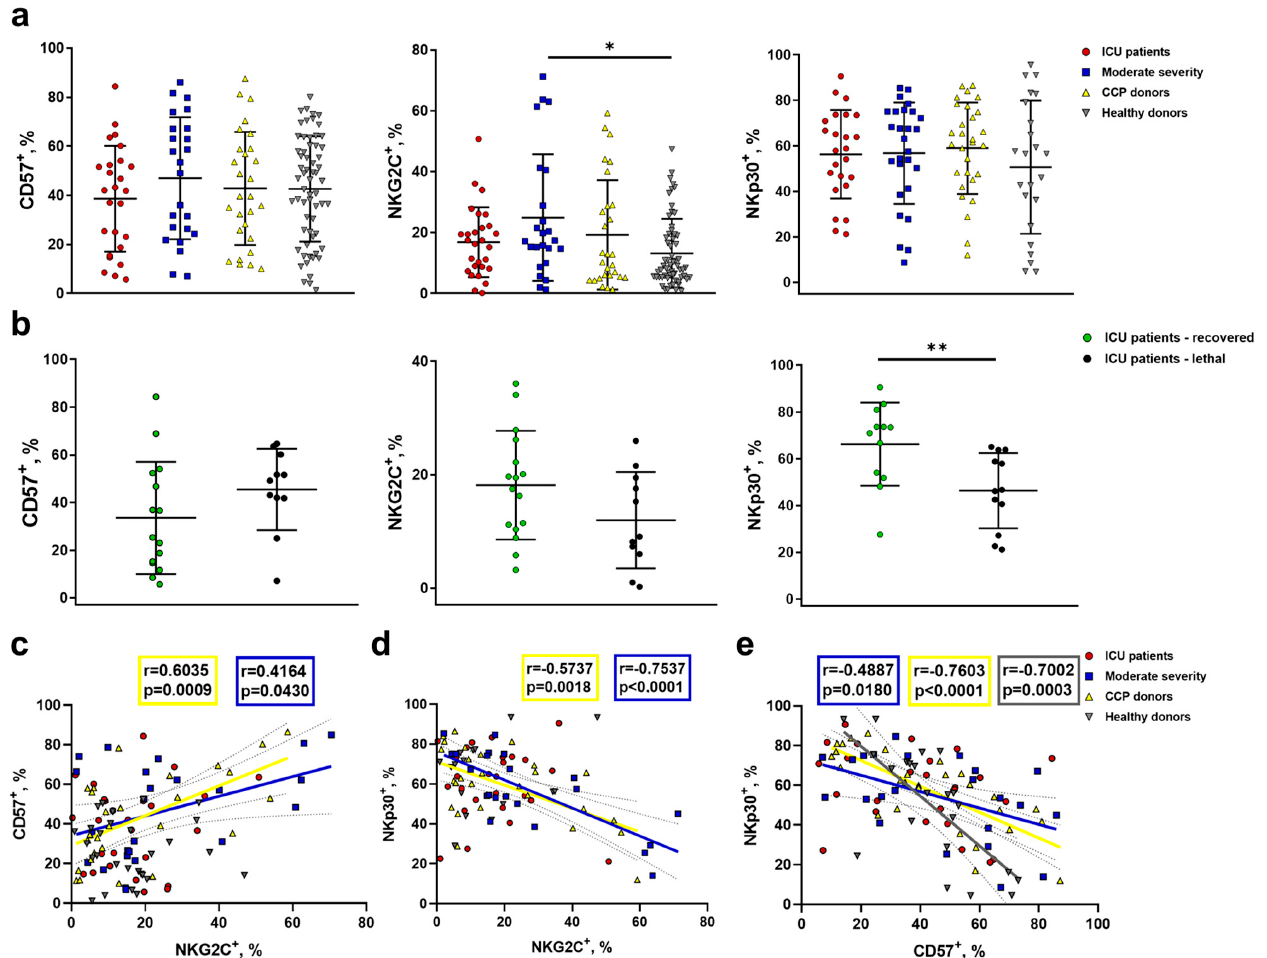
Figure 6. Analysis of NKG2C, CD57, and NKp30 expression in NK cells from COVID-19 patients, convalescent patients, and healthy donors. ( a ) The proportion of CD57 + , NKG2C + , and NKp30 + NK cells measured in the following comparison groups: ICU patients (n = 32), moderate-severity patients (n = 24), CCP donors (n = 35), and healthy donors (n = 27 for NKp30, n = 62 for CD57 and NKG2C). ( b ) Comparative analysis of CD57 + , NKG2C + , and NKp30 + NK cells in recovered and lethal ICU patients from the ICU group. ( c ) Pearson correlation between the proportions of CD57 + and NKG2C + NK cells in all donor groups. ( d ) Pearson correlation between the proportions of NKp30 + and NKG2C + NK cells in all donor groups. ( e ) Pearson correlation between the proportions of NKp30 + and CD57 + NK cells in all donor groups. ( a , b ) Data are presented as individual values with mean ( ± SD). * p < 0.05, ** p < 0.01.